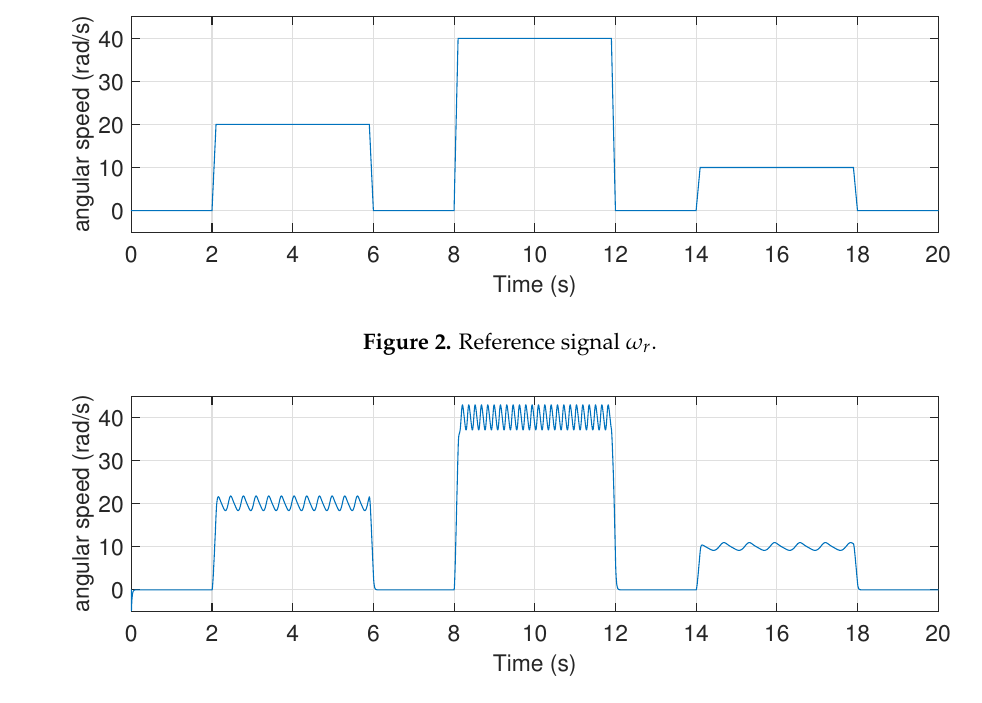
Figure 3. Simulation result: motor angular speed ω under the PI